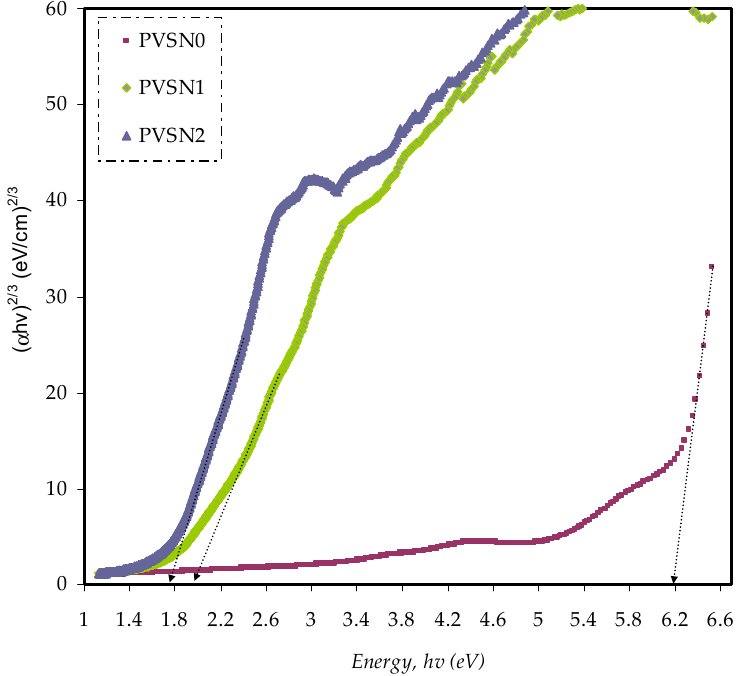
Figure 13. Plot of ( α h υ ) 2/3 vs. h υ for pure PVA and PC films.